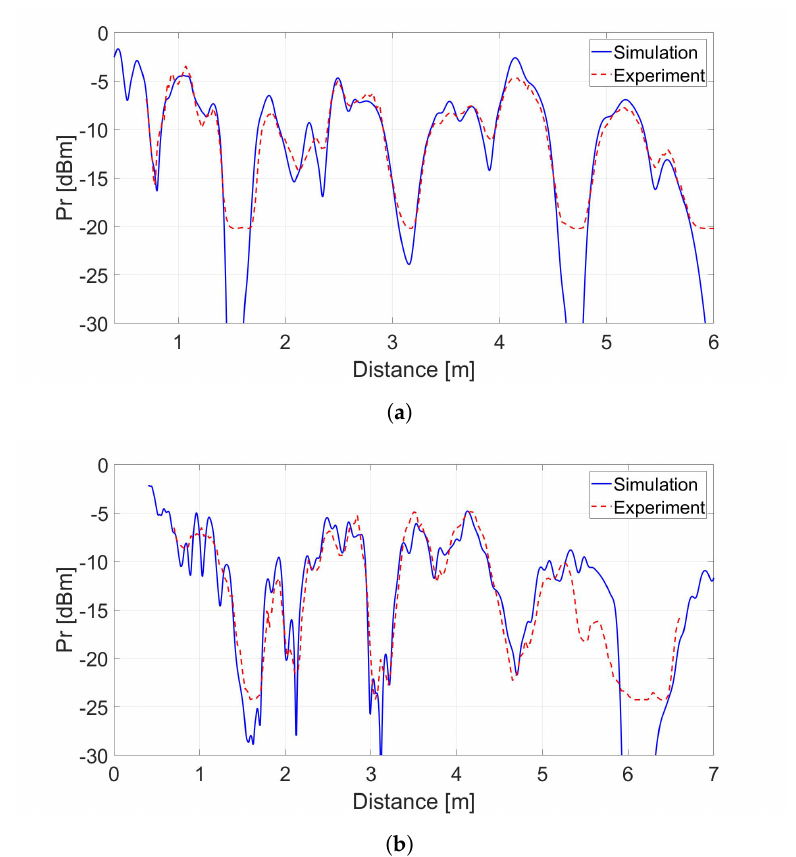
Figure 12. Comparison of the simulation and experimental results of directive links for different polarizations while considering the radiation pattern of transmitting and receiving antennas. ( a ) Vertical polarization. ( b ) Horizontal polarization.